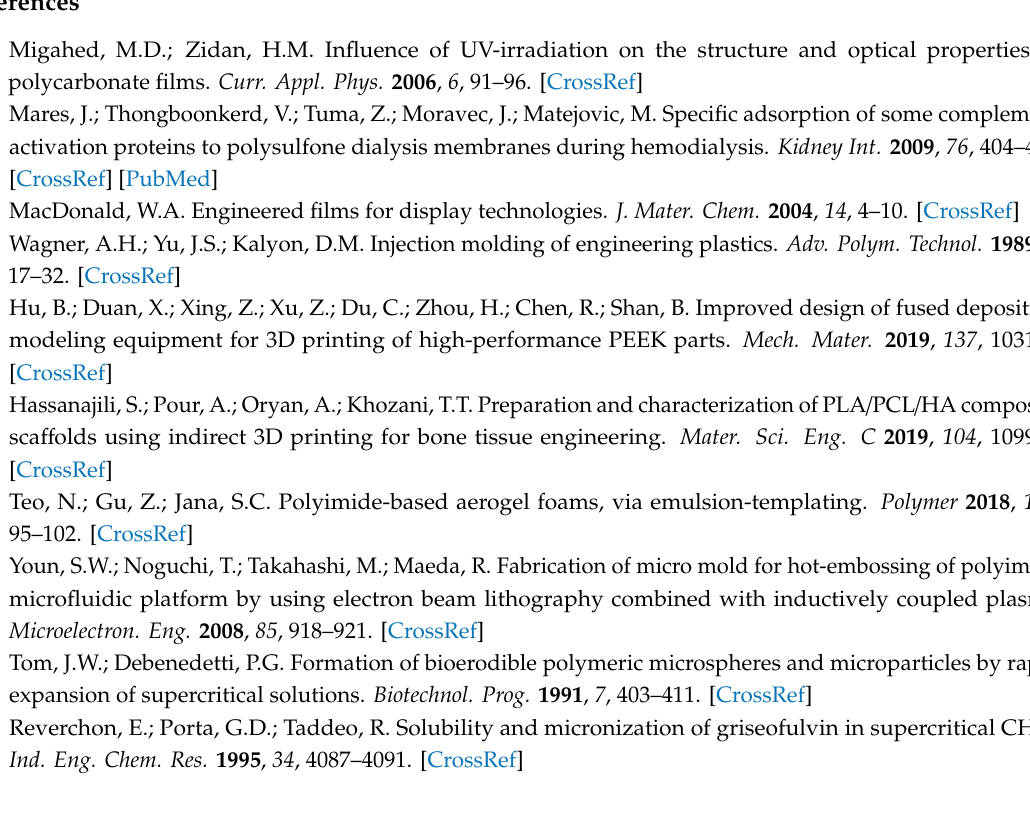
Figure S1: Amount of CO 2 used in plasticizing PLLA. The amount of CO 2 in PLLA was analyzed using Temperature Programmed Desorption-Mass Spectrometry (TPD–MS). The amount of CO 2 released upon heating using a heater at 80 ◦ C (Small-8, TRC Co., Ltd., Tokyo, Japan) was analyzed using MS (GC / MS QP2010(9), Shimazu Co., Ltd., Kyoto, Japan). CO 2 was released upon melting PLLA (after supercritical treatment), but small amounts of CO 2 continued to be released even after 100 min. Untreated PLLA (before supercritical treatment) did not release CO 2 . As mentioned in Table 2, the amounts of CO 2 released in experiments 1 (slight melting) and 3 (enough melting) were 360 wt ppm and 7500 wt ppm,